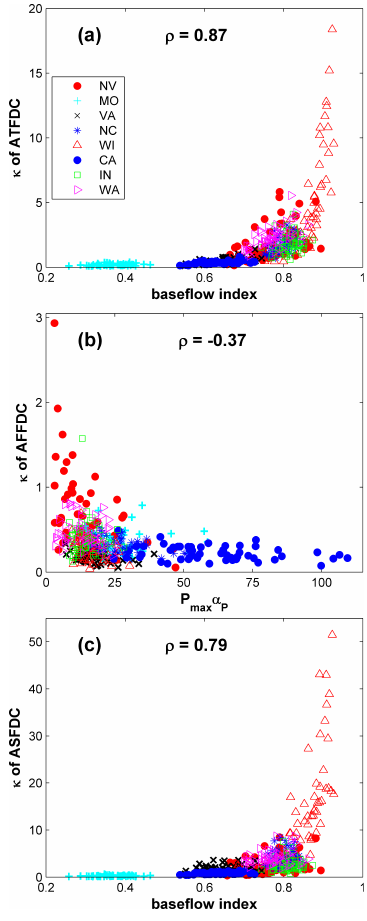
Fig. 8. Correlation of parameter κ of TFDC, FFDC and SFDC of 197 catchments (between catchment variability) with catchment physical characteristics.